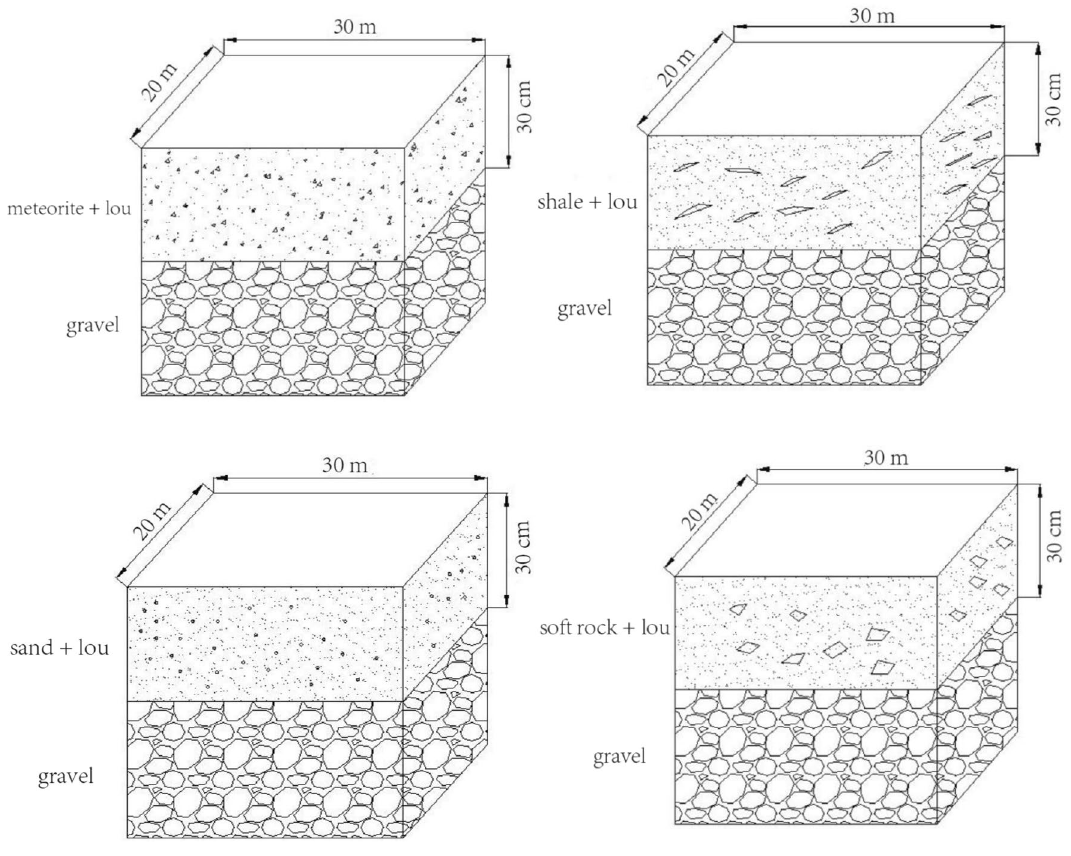
Figure 1. Stereograms of the test sample.